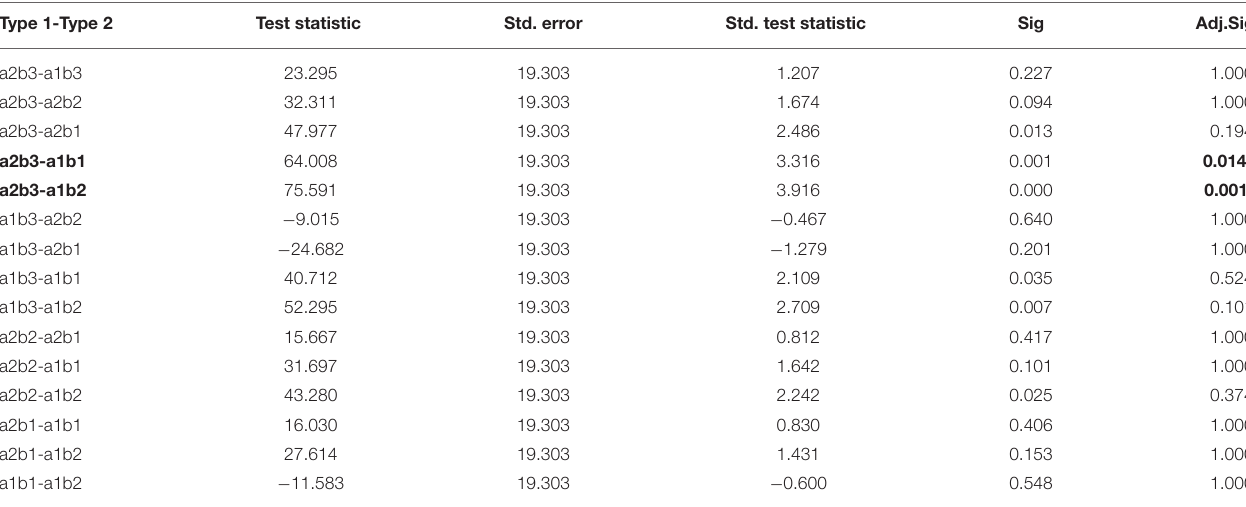
TABLE 4 | Pairwise comparison of photo types in concern.